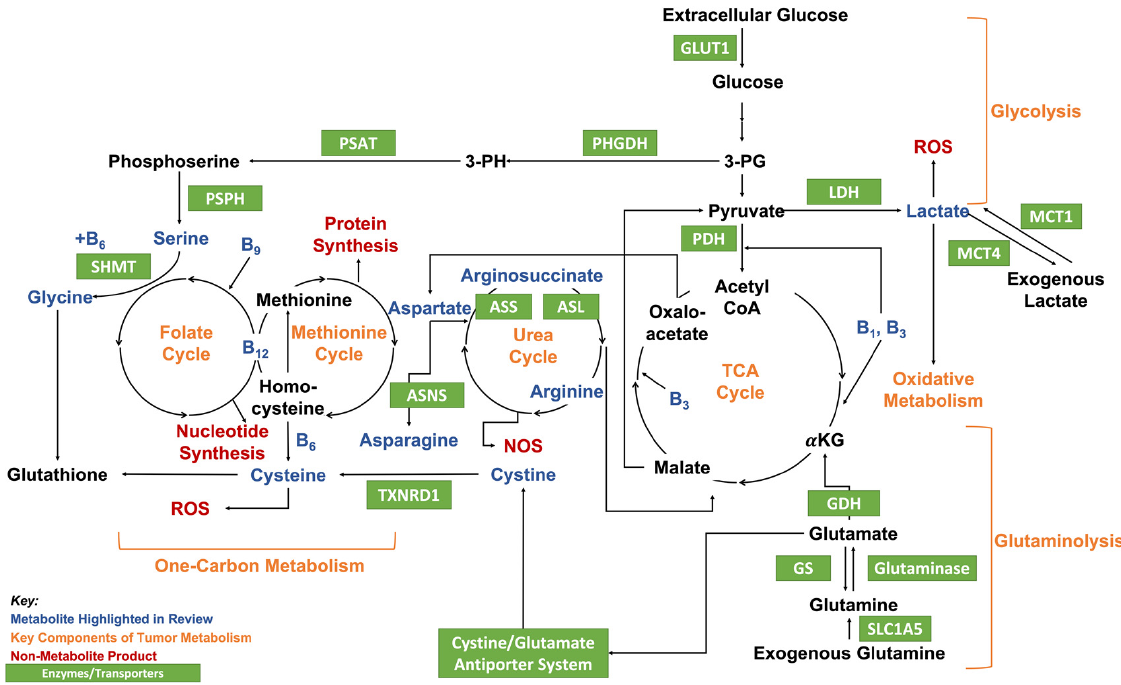
Figure 1. Complex mechanisms induced by glucose, glutamine, and lactate uptake encompass the metabolism of tumor cells. 3-PG: 3-phosphoglycerate, 3-PH: 3-phosphohydroxypyruvate, ASL: arginosuccinate lyase, ASNS: asparagine synthetase, ASS: arginosuccinate synthase, α KG: alpha-ketoglutarate, GDH: glutamine dehydrogenase, GS: glutamine synthetase, LDH: lactate dehydrogen- ase, MCT1/4: monocarboxylate transporter 1/4, NOS: nitric oxide synthase, PDH: pyruvate dehy- drogenase, PHGDH: phosphoglycerate dehydrogenase, PSAT: phosphoserine aminotransferase, PSPH: phosphoserine phosphatase, ROS: reactive oxygen species, SHMT: serine hydroxymethyl- transferase, TXNRD1: thioredoxin reductase 1.